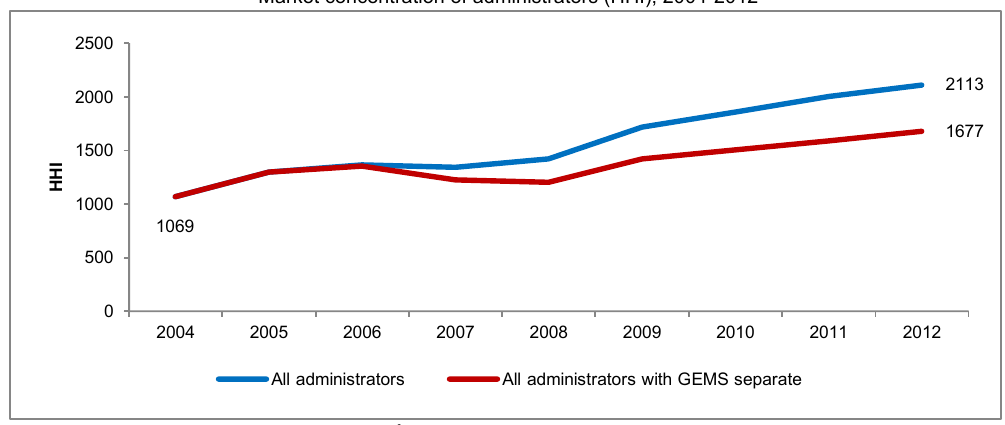
Market concentration of administrators (HHI),